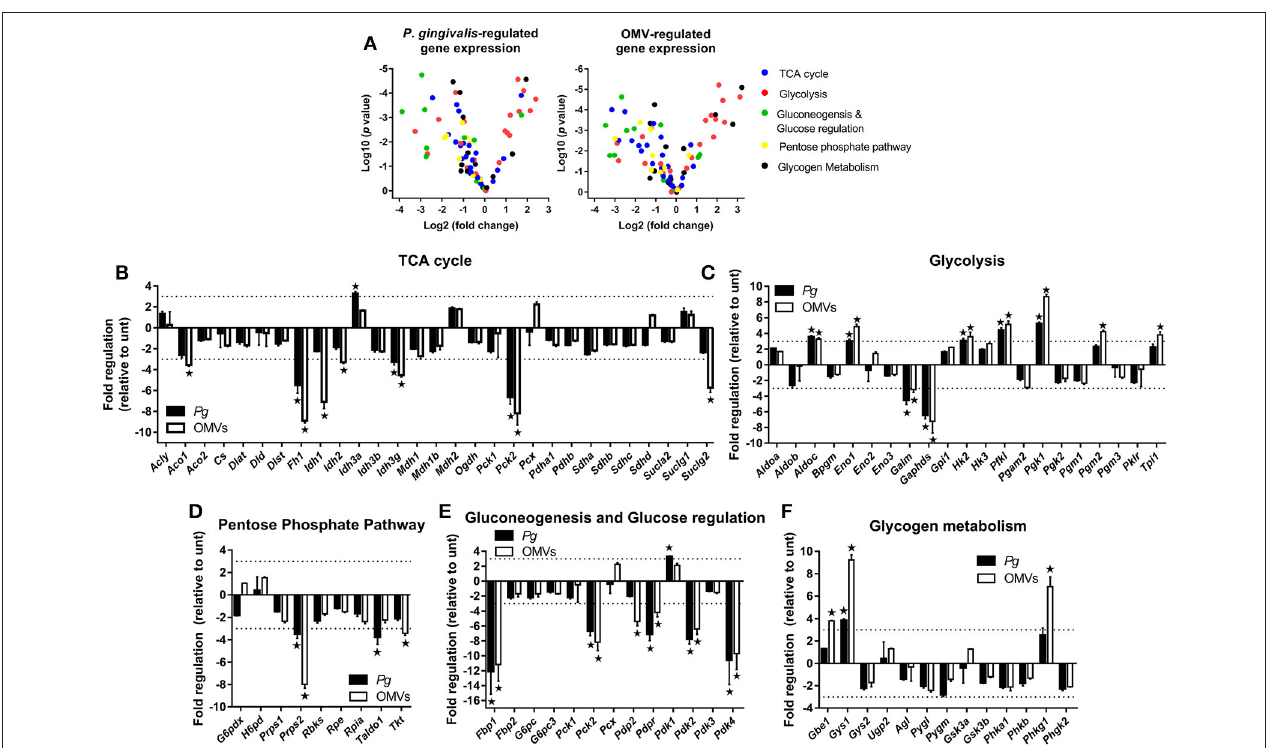
FIGURE 4 | P. gingivalis and its OMVs regulate macrophage metabolic gene expression. (A) Volcano plots showing genes differentially expressed in BMM following infection with P. gingivalis or OMVs (25:1 MOI, see Materials and Methods) relative to untreated BMM after 24 h using a Glucose Metabolism PCR Array (PAMM-006Z). RNA was purified for cDNA synthesis and qPCR performed and (B–F) genes are grouped according to function and expression is shown relative to untreated BMM. Data are mean ± SD from three independent experiments. Genes with greater than three-fold difference from untreated cells (indicated with dotted line) were considered significant (* p <